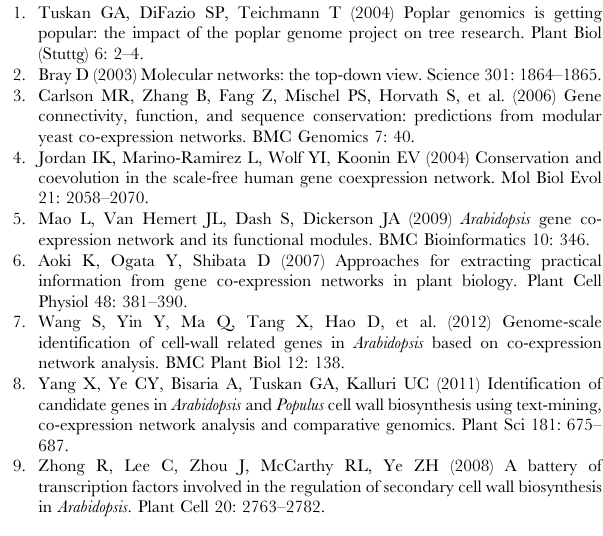
Table S1 List of the significant co-expression relation- ships among genes in each module in AGCN. Table S2 Significantly overrepresented biological pro- cess GO terms in AGCN modules. Table S3 Arabidopsis genes of Module 27 in AGCN. Table S4 GO enrichment for the 1,998 new candidate plant cell wall genes found in AGCN. Table S5 Experiment series of Populus gene chips used for co-expression network construction. Table S6 List of the significant co-expression relation- ships among genes in each module in PGCN. Table S7 Significantly overrepresented biological pro- cess GO terms in PGCN modules. Table S8 Best-hit homologous genes in Arabidopsis of the Populus genes in Module 4. Table S9 Best-hit homologous genes in Arabidopsis of the Populus genes in Module 9. Table S10 GO enrichment for the 492 new candidate plant cell wall genes found in